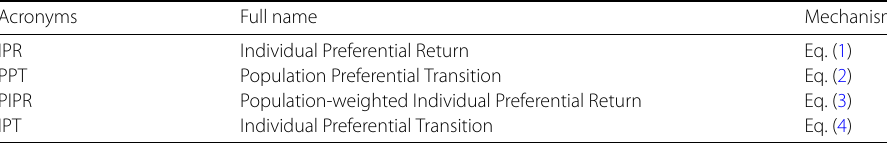
Table 1 Acronyms for the studied human mobility